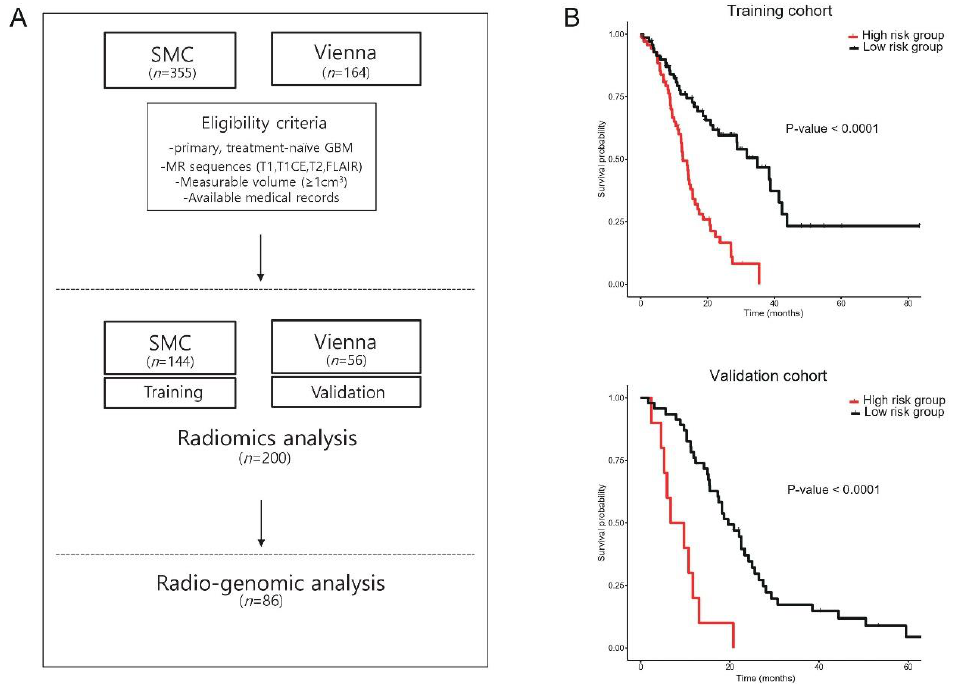
Figure 1. Radiomics workflow. The feasibility of radiomics as an imaging biomarker for glioblastoma (GBM) patients was evaluated through following study platform. ( A ) Schematic illustration of radiomics flowchart in present study; ( B ) survival plots of GBM patients stratified by radiomics risk score, a weighted sum of selected features (above, training cohort; below, validation cohort).